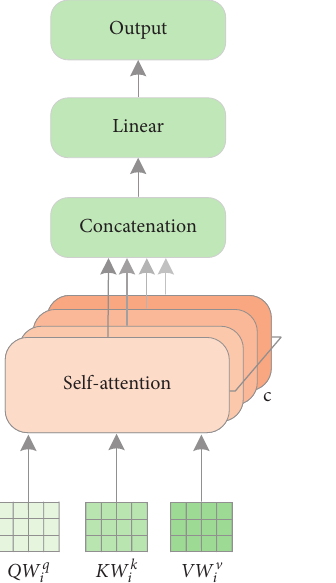
Figure 6: The structure of multihead attention